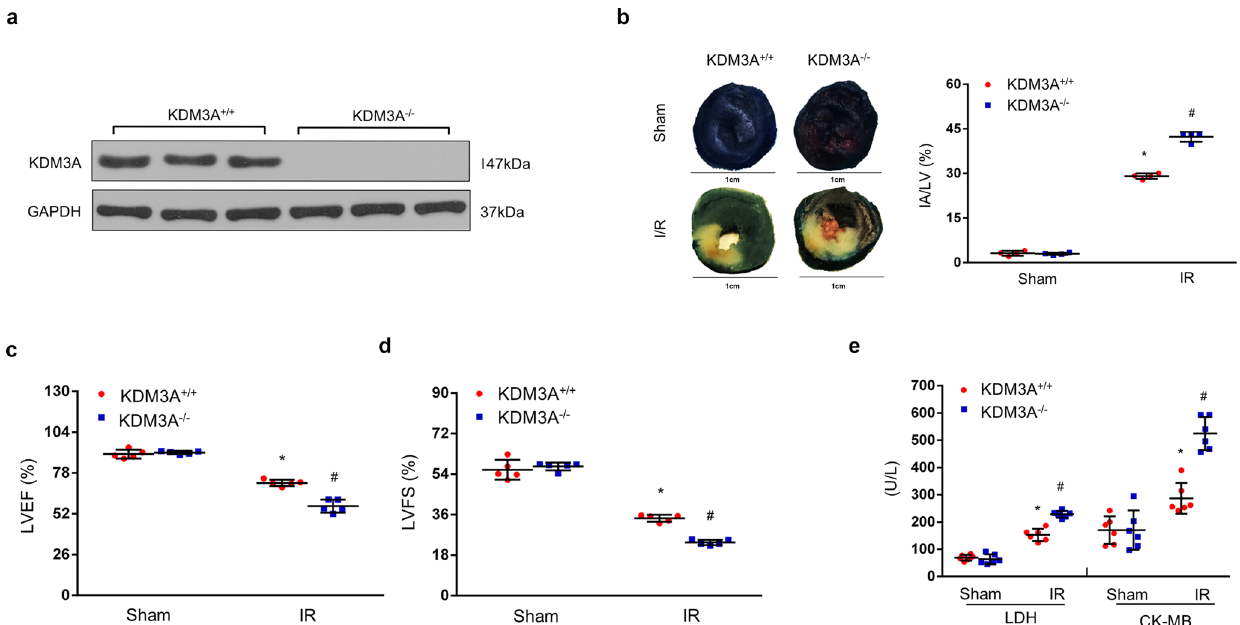
Fig. 4 KDM3A knockout exacerbates I/R-induced myocardial injury. a Representative western blots of KDM3A protein expression in heart tissue from KDM3A + / + and KDM3A − / − ( n = 6). b Representative section images (left panel) and averaged data of the ratio of IA to total left ventricular area (right panel) after sham or I/R surgery (n = 4). Scale bar = 1 cm. c , d Statistical analysis of echocardiographic parameters (LVEF and LVFS) indicating left ventricular function upon MIRI or sham operation in the indicated groups ( n = 5). e Myocardial damage was estimated by LDH/CK-MB concentrations in the serum with or without MIRI ( n = 6). * p < 0.05 vs . KDM3A − / − /sham; # p < 0.05 vs. KDM3A + / +